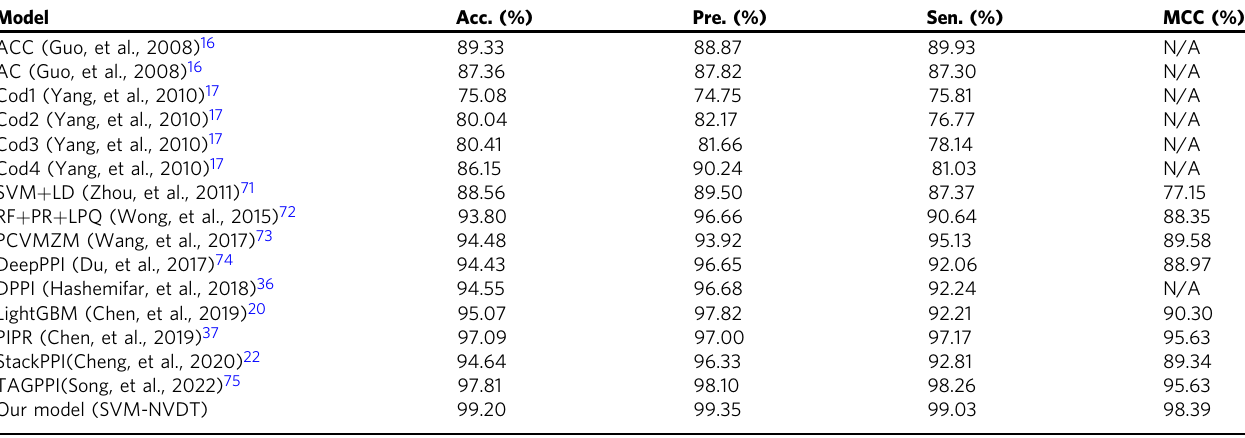
Table 5 Comparison of established methods using the S. cerevisiae dataset.